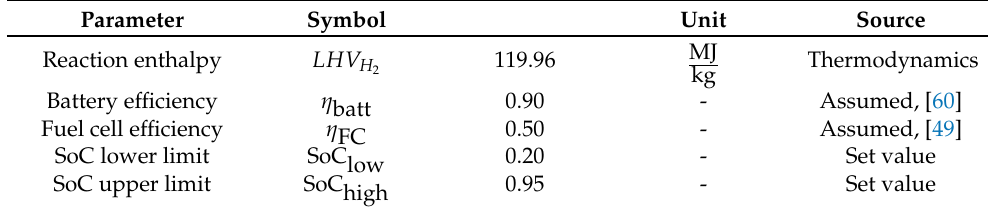
Table 11. Electrochemical Parameters for the hybrid fuel cell and battery system. Parameter Symbol Unit Source Reaction enthalpy LHV H Thermodynamics 119.96 MJ 2 kg Battery efficiency η batt 0.90 - Assumed, [60] Fuel cell efficiency η FC 0.50 - Assumed, [49] SoC lower limit SoC low 0.20 - Set value SoC upper limit SoC high 0.95 - Set